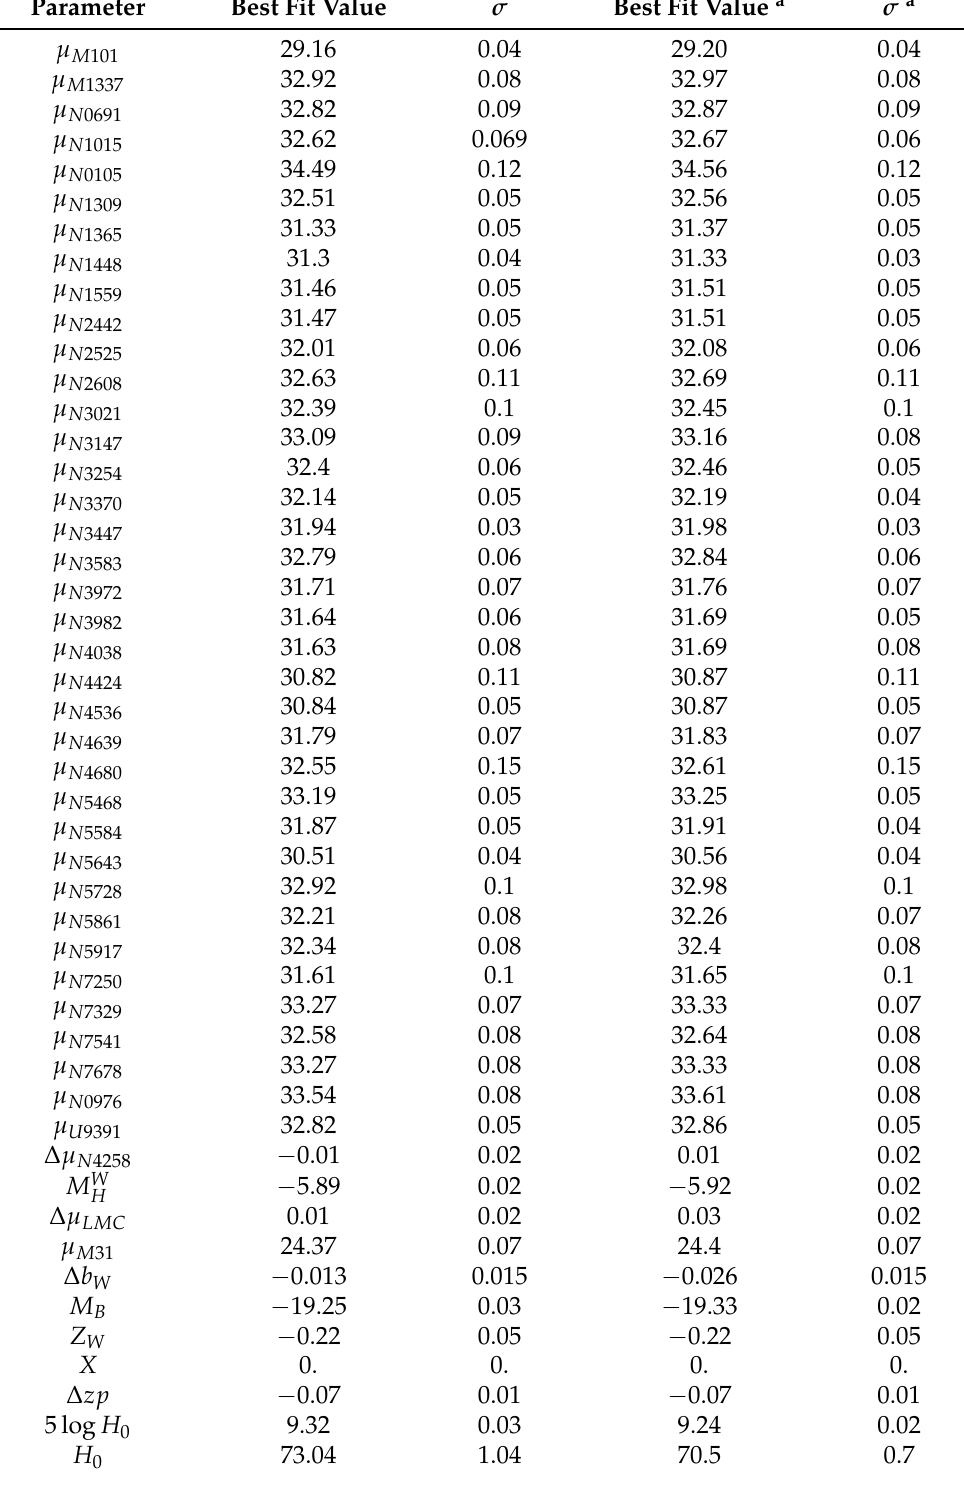
Table 2. Best-fit parameter values in the absence and in the presence of the inverse distance ladder constraint for baseline